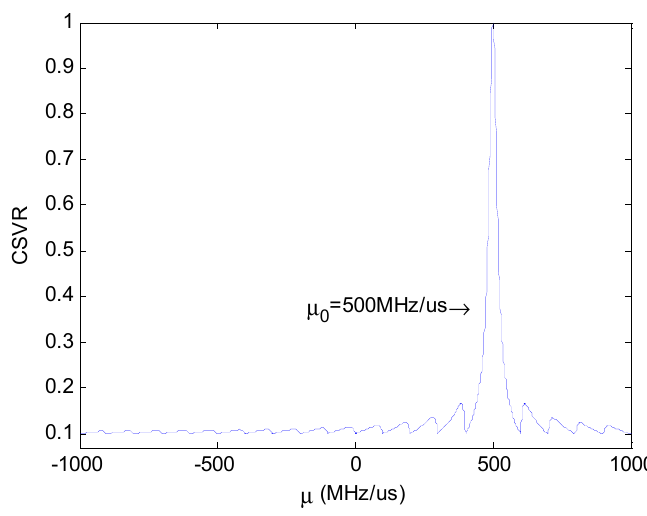
Figure 5. CSVR spectrum using periodic LFM LOS.